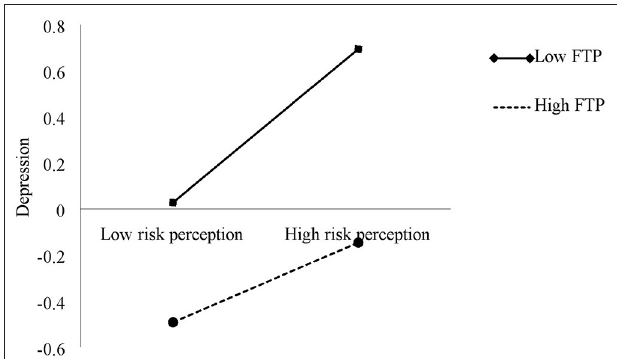
FIGURE 2 | The interactive effect of future time perspective and risk perception on